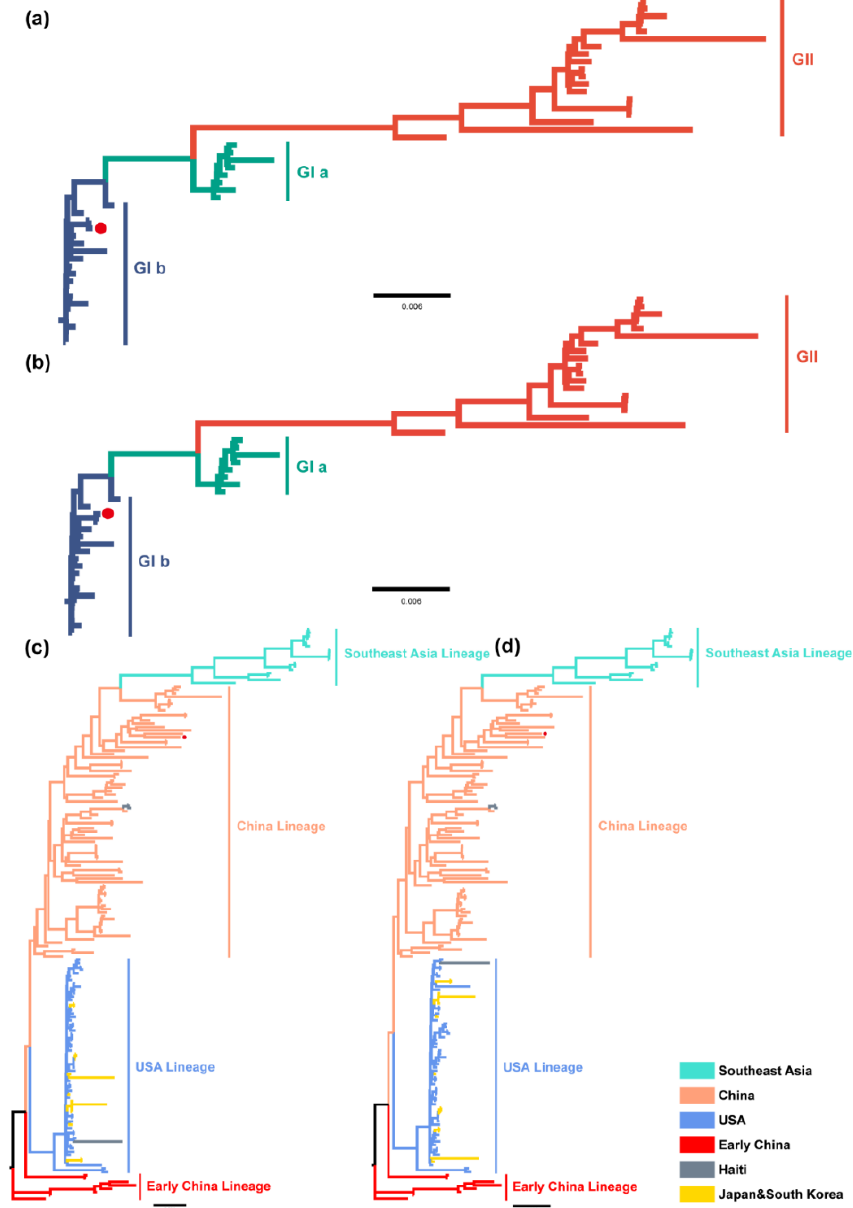
Figure 3. ML tree and BI tree of TGEV and PDCoV. ( a ). ML tree of TGEV complete genome. ( b ). BI tree of TGEV complete genome. Different colors represented different genotypes. ( c ). ML tree of PDCoV complete genome. ( d ). BI tree of PDCoV complete genome. Different colors indicated different genotypes/lineages.